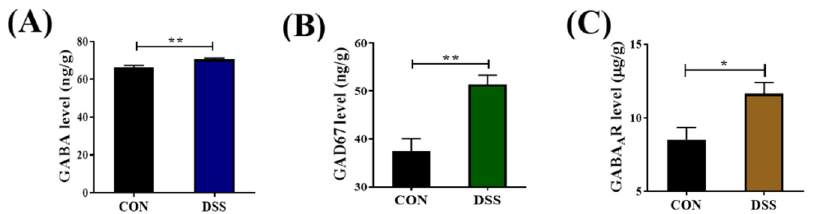
Figure 1. The expression levels of GABAergic signaling proteins were upregulated in the colon of ulcerative colitis (UC) mice. The levels of ( A ) GABA, ( B ) GAD67, and ( C ) GABA A R in the colon of DSS − induced mice were detected by ELISA kits. Data are presented as mean ± SEM ( n = 5 per group). * p < 0.05, ** p < 0.01 vs. the control